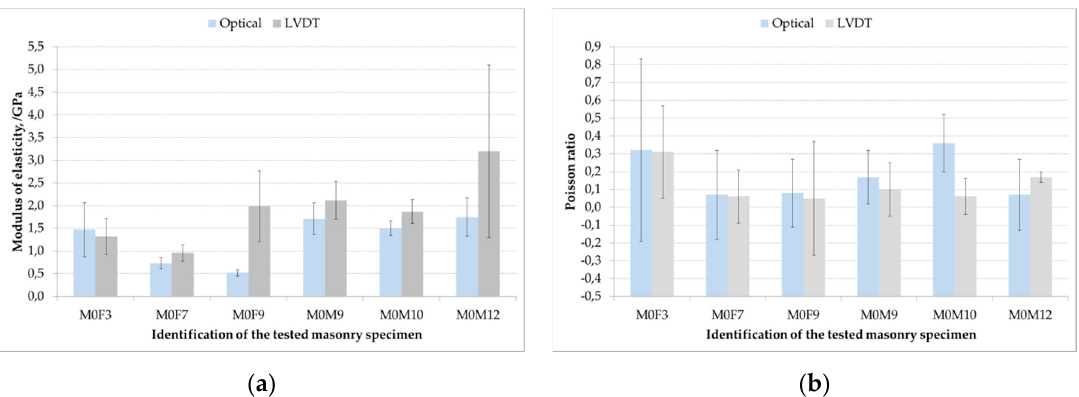
Figure 16. Estimates and standard uncertainties obtained from the optical and the contact measurement systems for ( a ) the modulus of elasticity; ( b ) and the Poisson ratio.